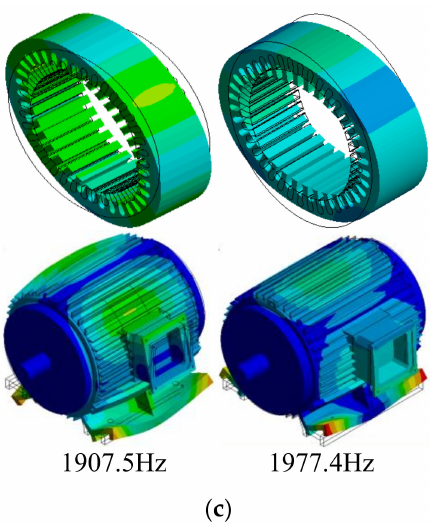
Figure 9. Modal shapes of the stator and the whole motor. ( a ) The first modal shape; ( b ) The second modal shape; ( c ) The second radial modal shape.